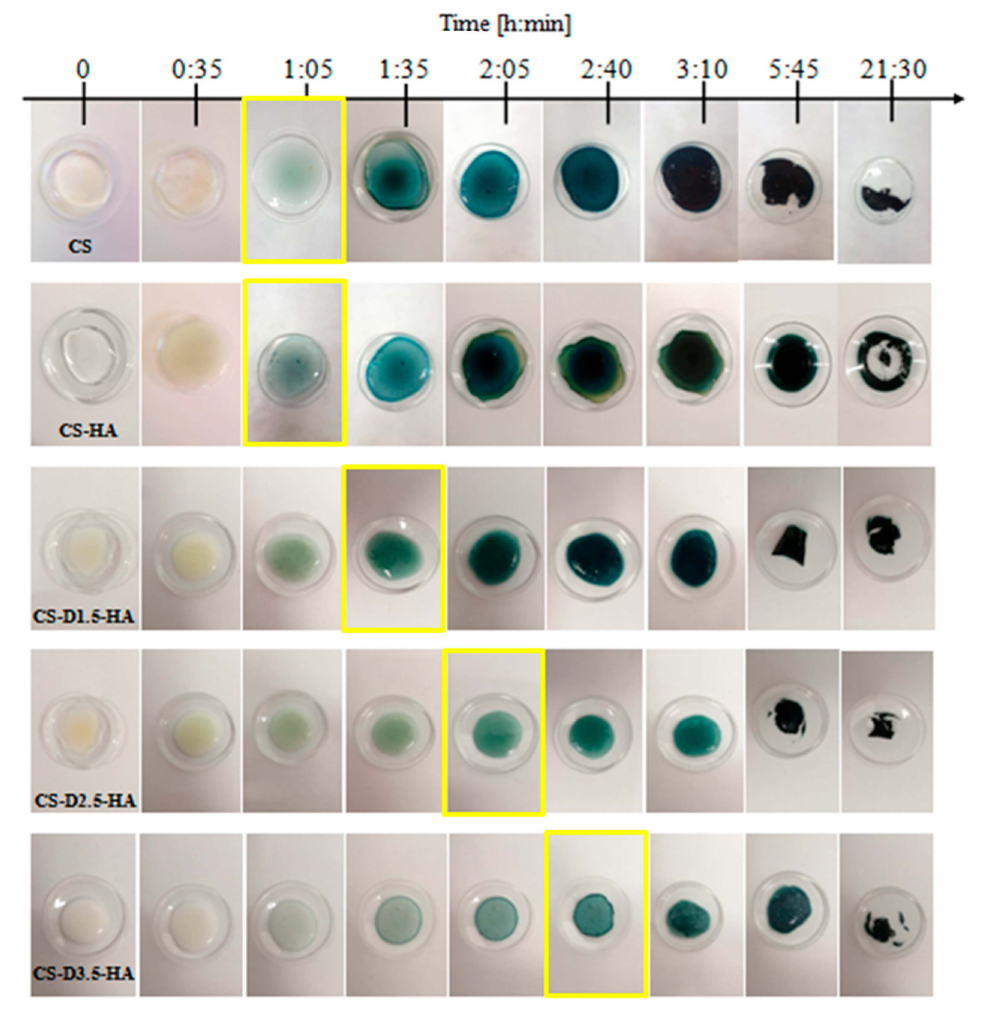
Figure 6. Photographs of the chitosan-based hydrogels collected during their cure reaction at 37 ◦ C. Polymers 2020 , 1 , x FOR PEER REVIEW 11 of 14